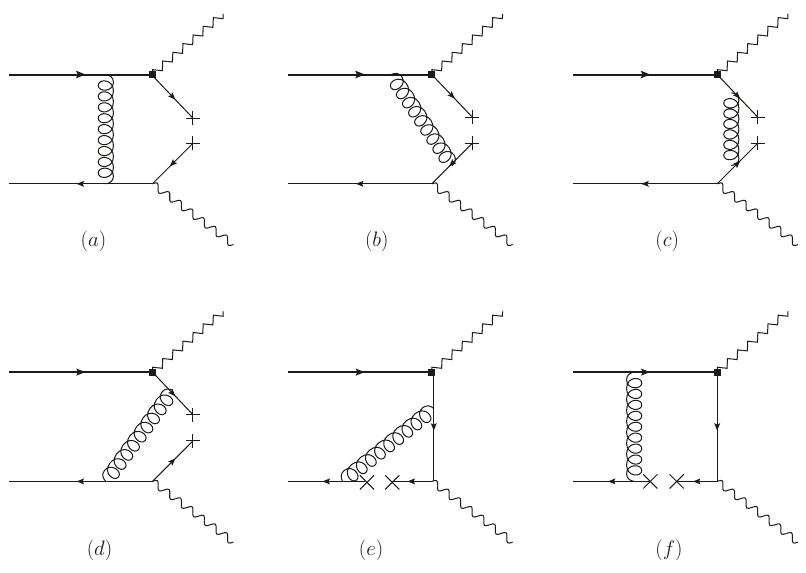
Figure 2 . Diagrammatic representations of the twist-five and twist-six four-particle corrections to the considered vacuum-to-bottom-meson correlation functions (2.2) at the O ( α